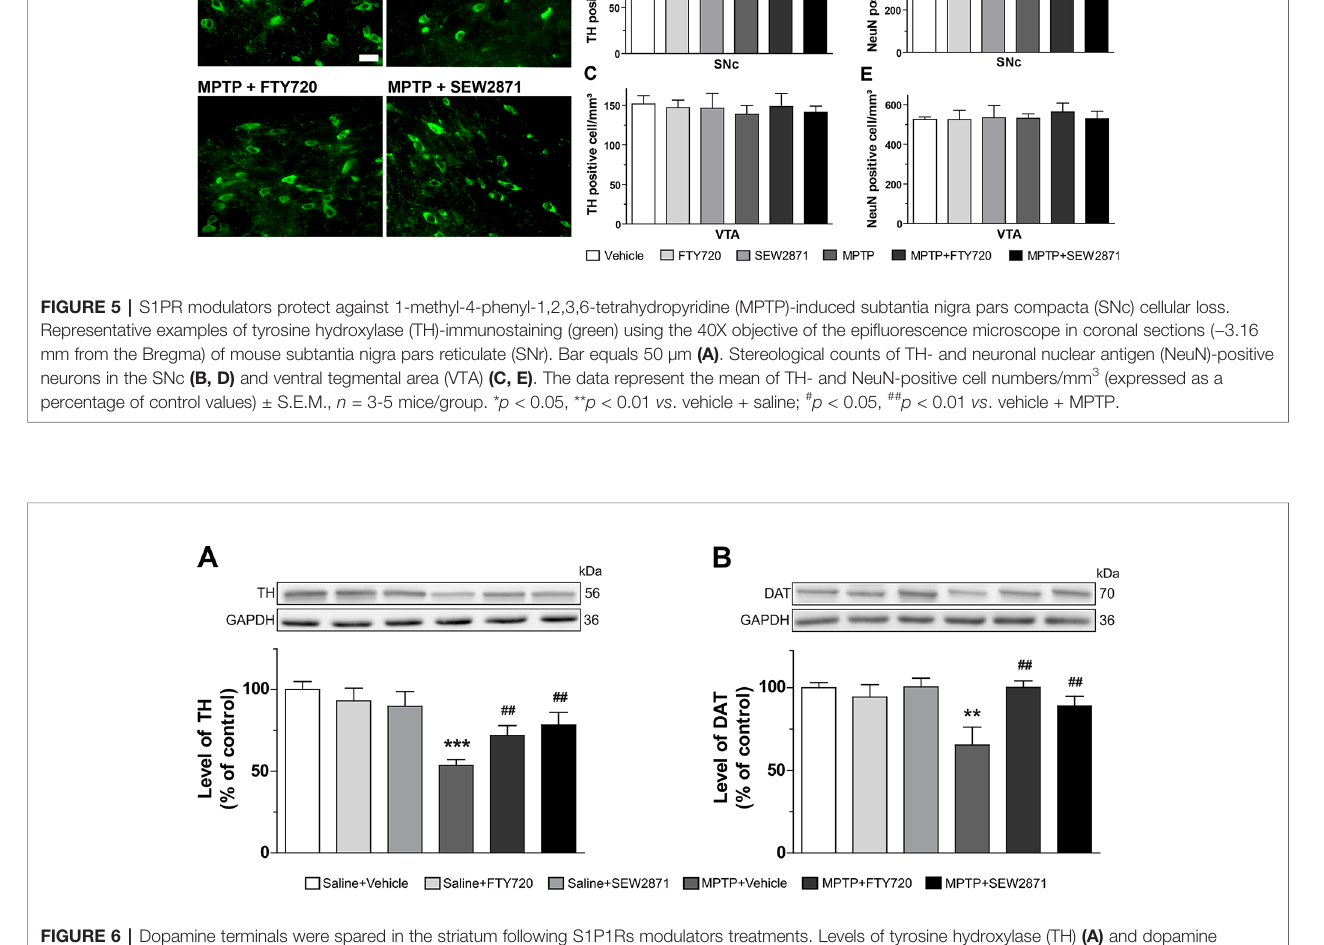
FIGURE 6 | Dopamine terminals were spared in the striatum following S1P1Rs modulators treatments. Levels of tyrosine hydroxylase (TH) (A) and dopamine transporter (DAT) (B) were determined in the mouse striatum by Western blot experiments. The data, expressed relative to GAPDH, represent the mean of relative optical density in triplicate experiments of TH and DAT (expressed as a percentage of control values) ± S.E.M., n = 3 – 5 mice/group. ** p < 0.01, *** p < 0.001 vs . vehicle + saline; ## p < 0.01 vs . vehicle +